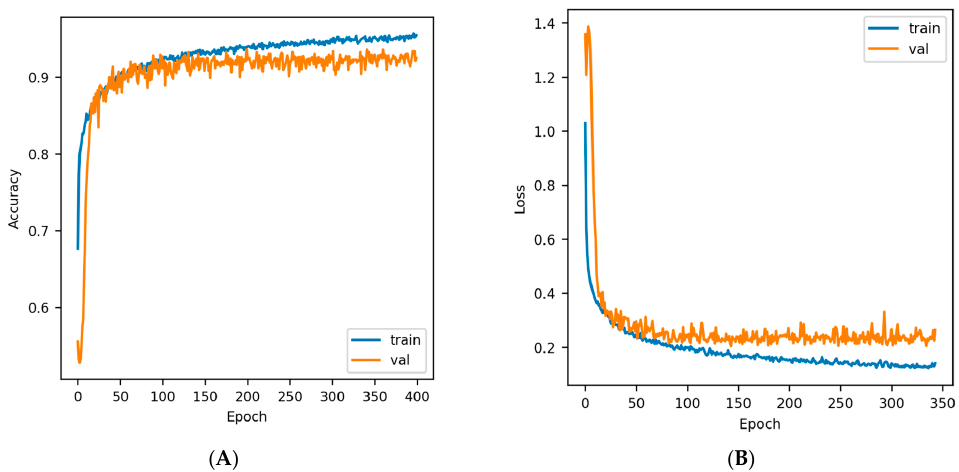
Figure 8. DNN training curves ( A ) Accuracy vs. Epoch; ( B ) Loss vs. Epoch.